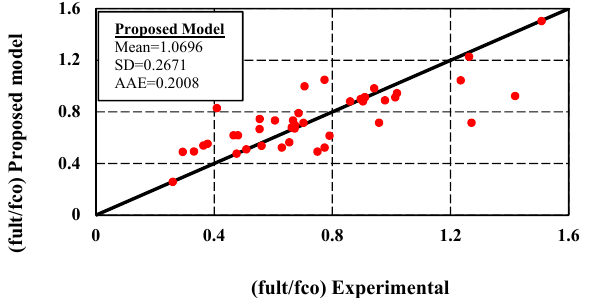
f ult 𝒇 𝒖𝒍𝒕 values obtained from the proposed model and experimental values obtained from the proposed model and experimental data . Figure 12. Comparison of f co 𝒇 𝒄𝒐